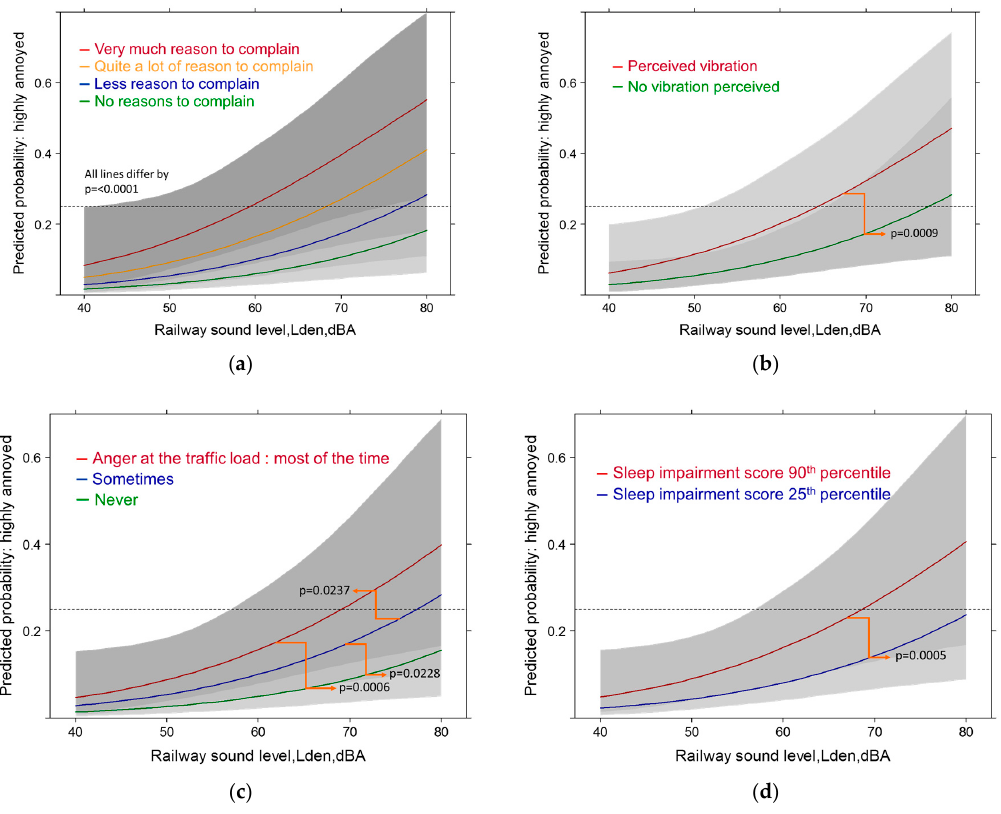
Figure 13. Predicted probability of high annoyance associated with railway sound exposure by ( a ) complaints about community soundscape; ( b ) perceived vibration. Models are adjusted for age, gender, education, health status, sleep score, distance to all sources, sensitivity to noise and air pollution, living duration, anger at traffic load, coping activities, perceived air pollution from road, general satisfaction with life, region. Predicted probability of high annoyance associated with railway sound exposure by ( c ) anger about traffic load and ( d ) perceived vibration. Models are adjusted for age, gender, education, health status, sleep score, distance to sources, sensitivity to noise/air pollution, living duration, complaints about community soundscape, anger at traffic load (not c ), perceived vibration (not d ), perceived traffic air pollution, general satisfaction with life, region).